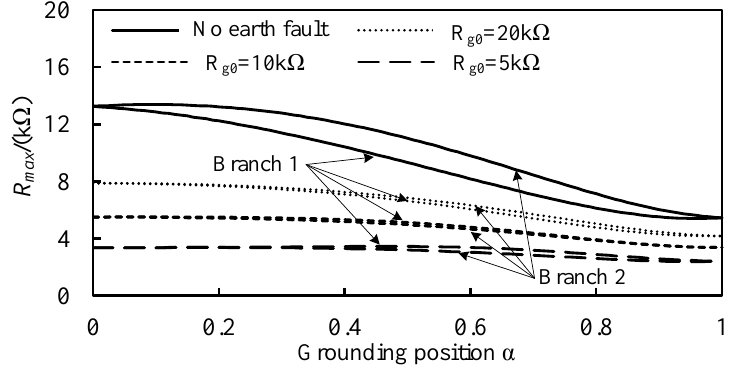
Figure 5. Sensitivity curves of the protection when the stator is already grounded by fault resistor R g 0 in the ungrounded mode.